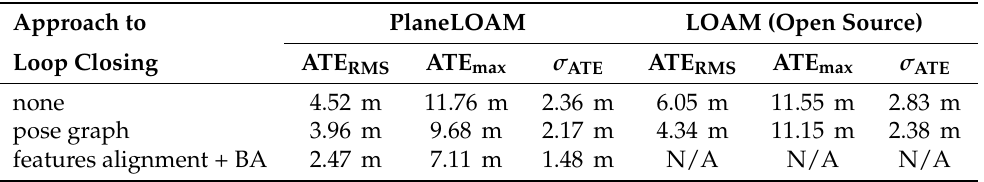
Figure 20. Estimated trajectories of the KITTI 00 ( A – C ) and MulRan DCC ( D – F ) sequences for the PlaneLOAM and open-source LOAM systems without any loop detection ( A , D ), with the SegMap loop detection method and two different approaches to loop closing: pose graph ( B , E ) or alignment of high-level features ( C , F ). Arrows point locations where the point clouds visualized in Figure 21 were acquired (see main text for details). Table 4. Comparison of ATE errors for different approaches to loop closing on the KITTI 00